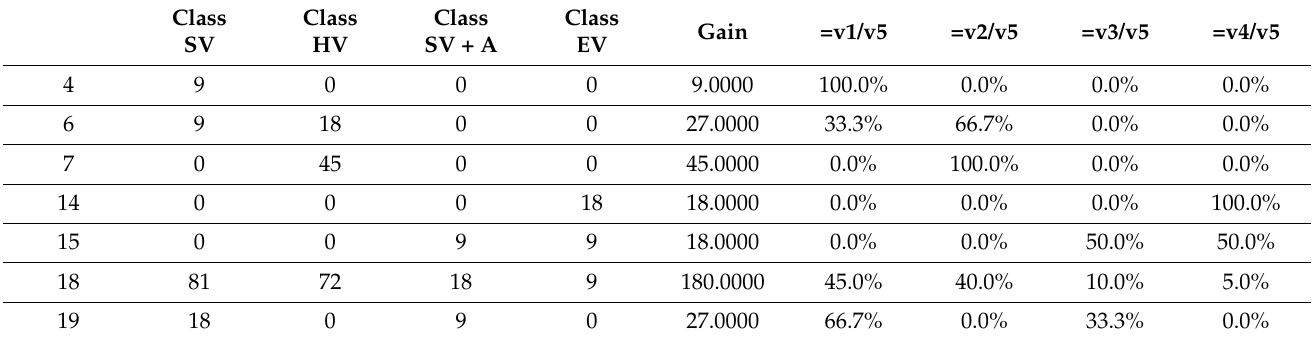
Table 3. Results in terminal nodes for the dependent variable: popularity of car type in the near future in the group of men. Model: